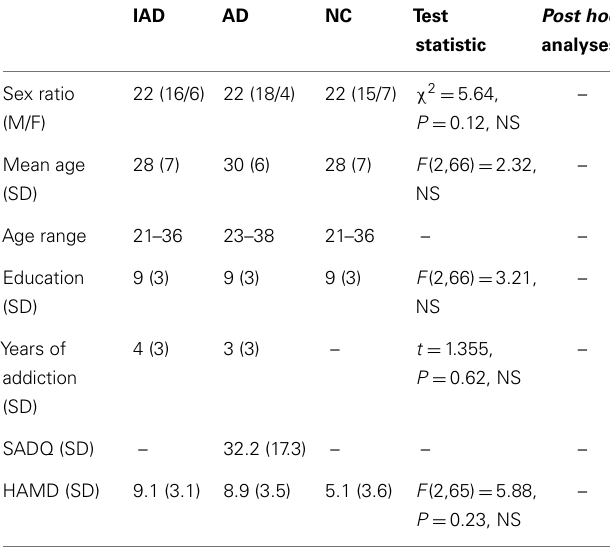
Table 1 | Demographic characteristics and clinical data of the sample